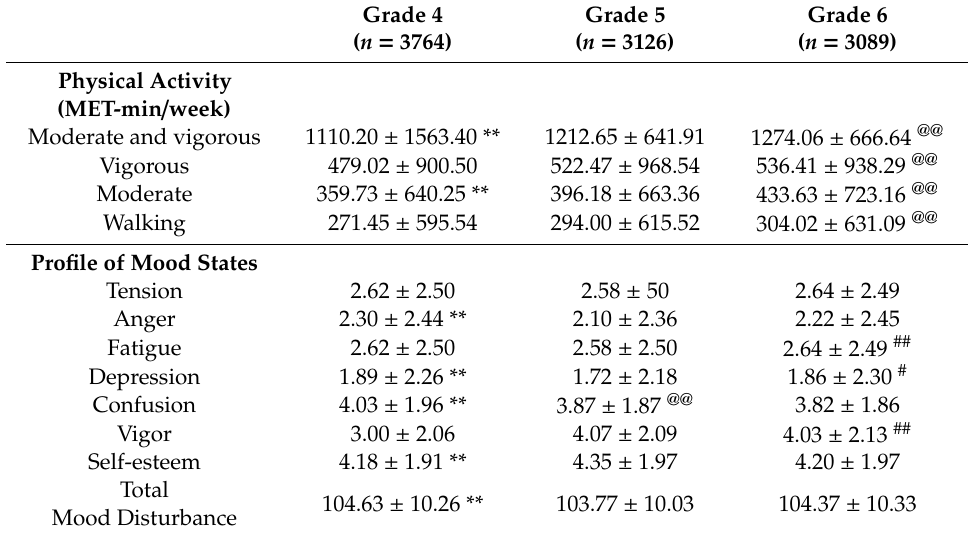
Table 3. The relationship between physical activity and mood states in di ff erent Grade groups ( N = 9979) (x ±